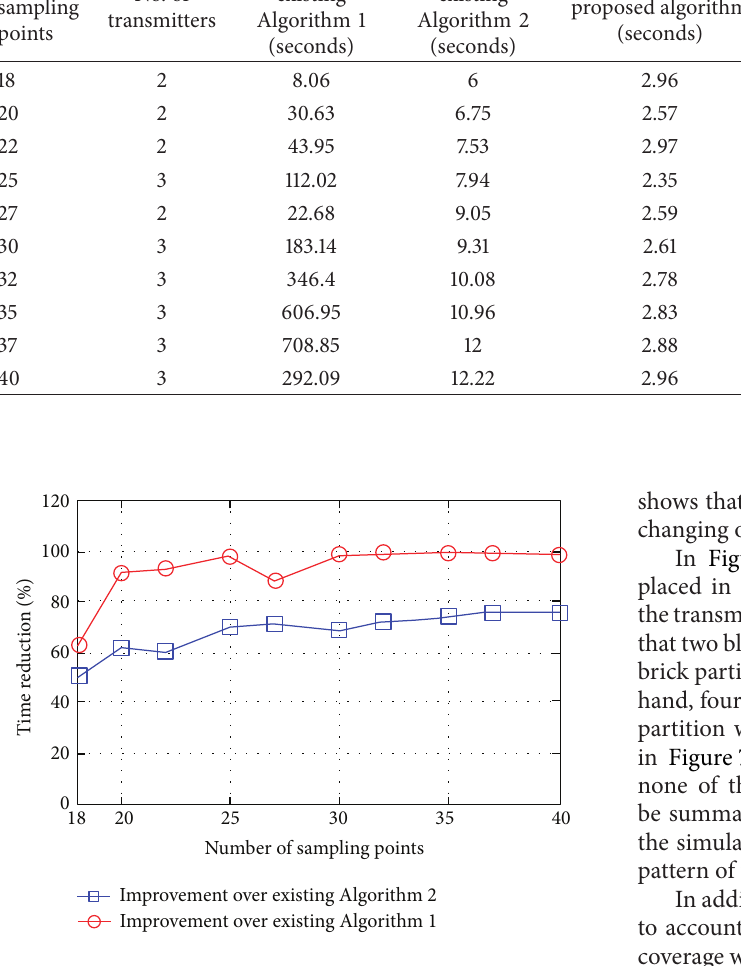
Figure 6: Improvement of the proposed algorithm over existing Algorithms 1 and